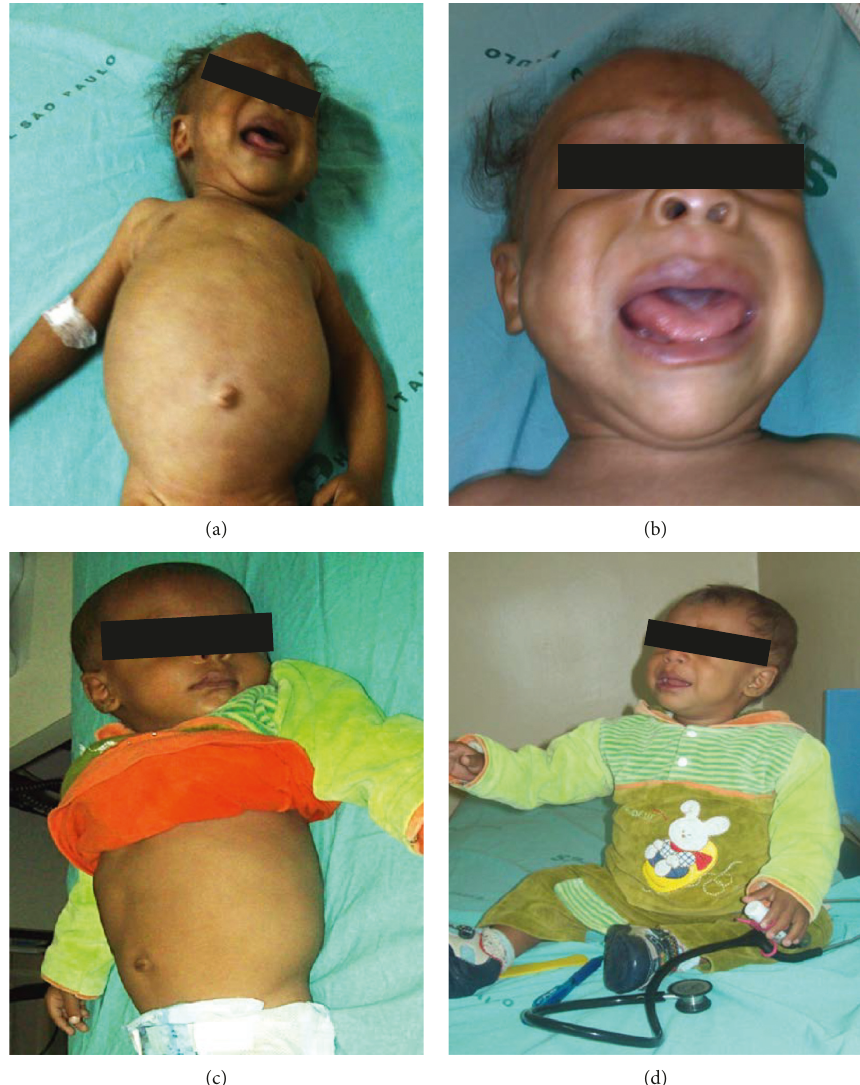
Figure 1: Patient at admission (a and b) and six months after adequate replacement with levothyroxine sodium tablets (c and d). (a) Irritability and severe abdominal distension. (b) Rarefied hair and eyebrows, and macroglossia. (c) Recovered clinical aspect and no abdominal distension. (d) Sitting without